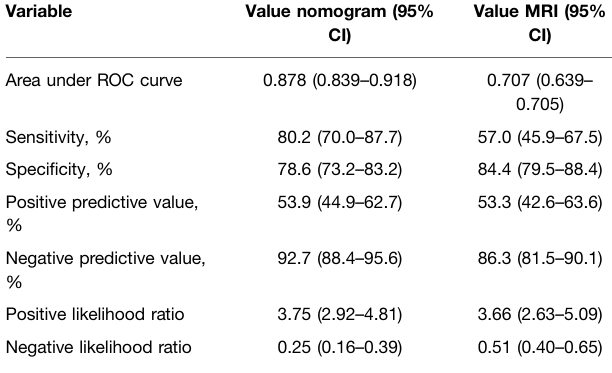
TABLE 2 | Diagnostic performance of nomogram and MRI in SSC